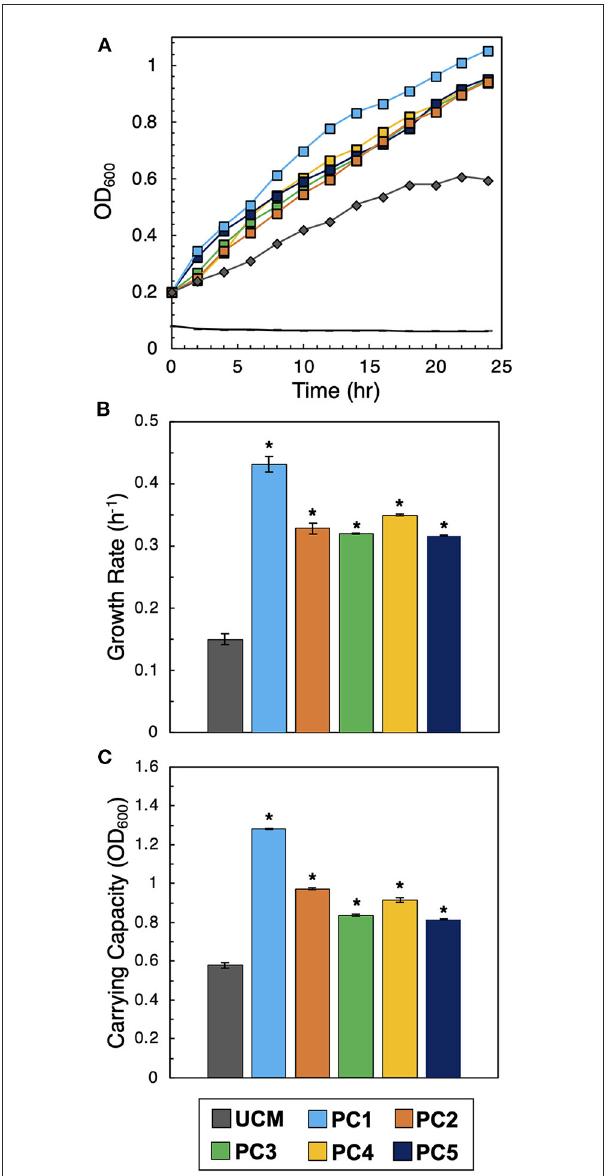
FIGURE4 Validation of interactions. (A) Sp7 growth curves after inoculation into unconditioned media (UCM) or conditioned media from each of the five consortia (PC1-PC5). The black control line represents conditioned media without Sp7. (B) Corresponding growth rates and (C) carrying capacities of Sp7 in UCM or media conditioned with the promoter consortia (PC1-PC5). Statistical differences were identified by comparing Sp7 growth metrics in consortia-conditioned media with Sp7 monoculture growth metrics in UCM (Wilcoxon two-sample test, * P < 0.01, n = 3 independent